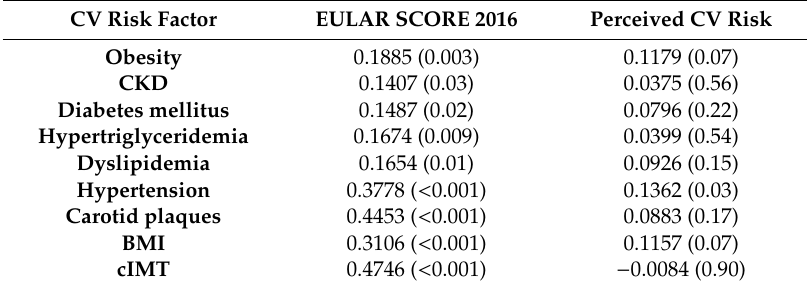
Table 4. Spearman correlation between cardiovascular risk factors and EULAR SCORE 2016 and cardiovascular risk